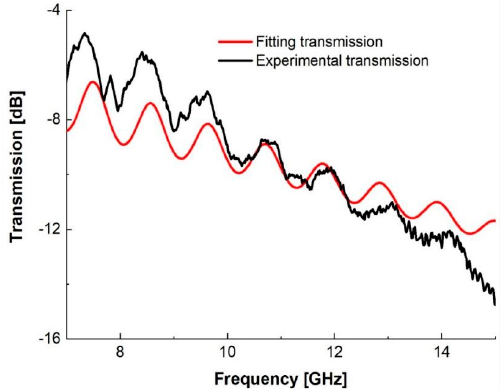
Figure 7. The experimental transmission and theoretical fitting transmission spectrum.